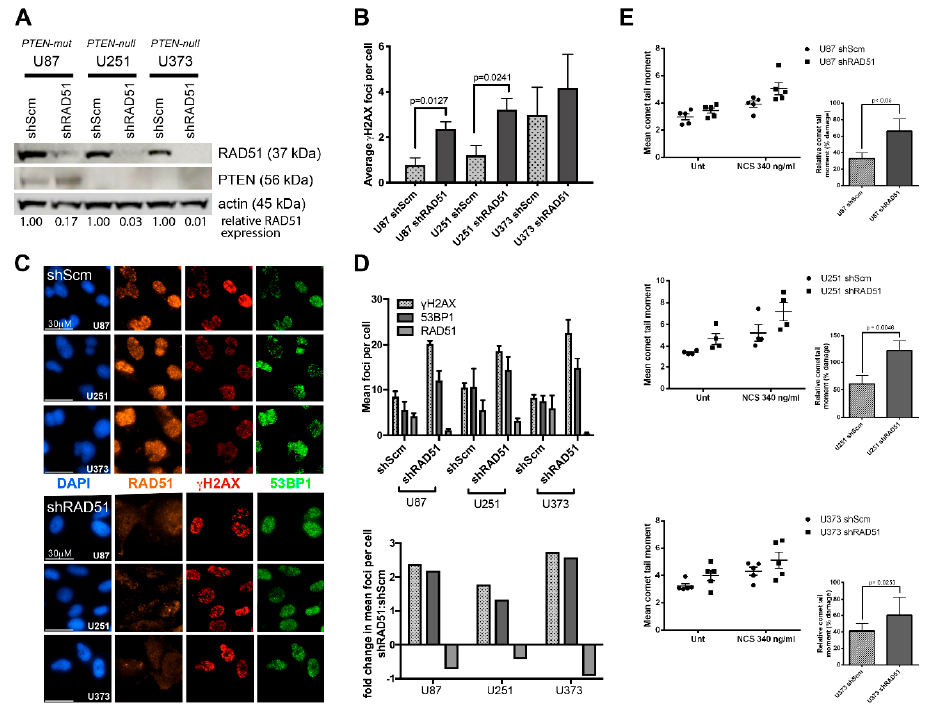
Figure 3. DNA repair analysis of PTEN ‐ deficient glioblastoma multiforme (GBM) cell lines. ( A ) Western analysis of PTEN ‐ deficient GBM cell lines stably expressing shRAD51 or shSCM (control). RAD51 knockdown in shRAD51 ‐ expressing GBM lines achieved ≥ 83% reduction in the RAD51 protein relative to shSCM ‐ expressing GBM counterparts (83% in U87MG; 97% in U251MG; and 99% in U373MG). Immunostaining with anti ‐ PTEN antibody confirms the reduced expression of mutant PTEN in U87 and loss of PTEN in U251 and U373. ( B ) Untreated shRAD51 ‐ GBM cells develop higher basal γ H2AX foci (DNA damage) in comparison to the untreated shSCM ‐ GBM counterparts. ( C ) Representative immunofluorescent micrographs and bar graphs quantifying γ H2AX, RAD51, and 53BP1 (phospho ‐ 53BP1 S1778 ) foci among shSCM ‐ and shRAD51 ‐ GBM cells following neocarzinostatin (NSC) ‐ induced DNA double ‐ strand breaks. Cellular treatment with NSC (140 ng/mL) induces γ H2AX and 53BP1 foci in both shSCM ‐ and shRAD51 ‐ GBM cells with only shSCM ‐ GBM cells showing concomitant RAD51 foci, while shRAD51 ‐ GBM cells fail to display RAD51 nuclear foci or signal. Scale bar represents 30 μ m. ( D ) Bar graphs quantify the mean number of DNA double strand break (DSB) ‐ dependent foci in all shSCM ‐ and shRAD51 ‐ GBM cells following 140 ng/mL NSC treatment. Only shSCM ‐ GBM cells show formation of RAD51 foci, while shRAD51 ‐ GBM cells do not. However, shRAD51 ‐ GBM cells display approx. 1.5–2.5× more 53BP1 foci compared to shSCM ‐ GBM cells. Statistical analysis was performed using the unpaired Student’s t ‐ test (U87 and U251, n = 4; U373, n = 3). ( E ) The effect of RAD51 depletion in glioblastoma tumor cell lines shown by the alkaline comet assay. Cells were exposed to NCS (340 ng/mL) for 1 h and the extent of NCS ‐ induced DNA damage was quantified using the alkaline comet assay. (Top graphs) Mean comet tail moment values of glioblastoma cells following NCS treatment and (Bottom graphs) DNA damage percentage relative to the untreated control. Increased DNA damage was observed in RAD51 ‐ knockdown cells in comparison to the SCM control as a result of the defective HR that is expected only in RAD51 ‐ deficient cells. A slight increase in DNA damage was also observed in all untreated RAD51 ‐ deficient GBM cells